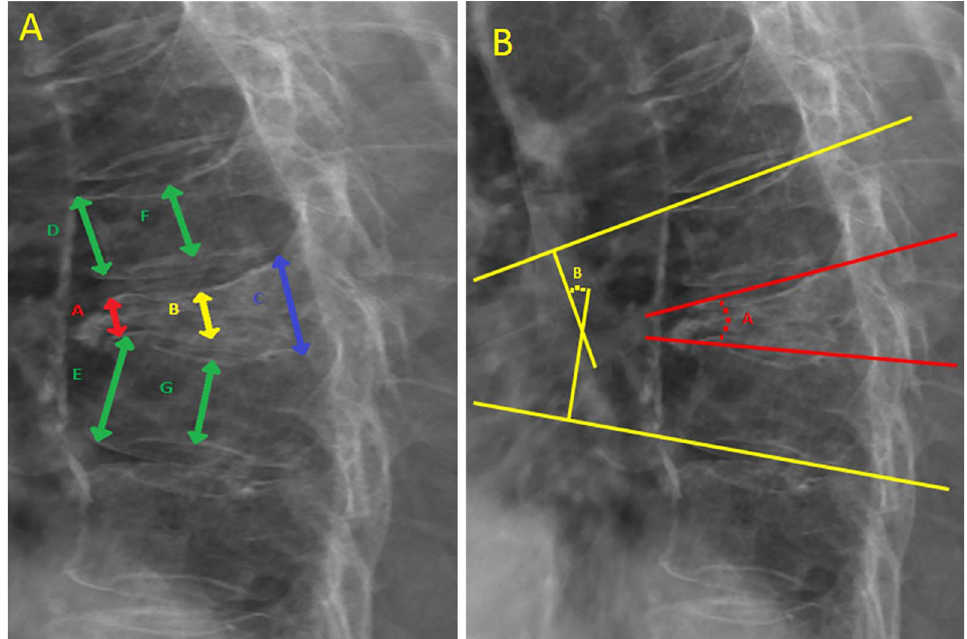
Figure 1. Demonstrated radiographic parameters. ( A ) Evaluation of the severity of compression fracture. A: anterior vertebral height, B: middle vertebral height, C: posterior vertebral height, D: superior anterior vertebral height, E: inferior anterior vertebral height, F: superior middle vertebral height, G: inferior middle vertebral height. ( B ) Measurement of sagittal angle of the fractured vertebrae. A: local kyphotic angle, B: Cobb angle.